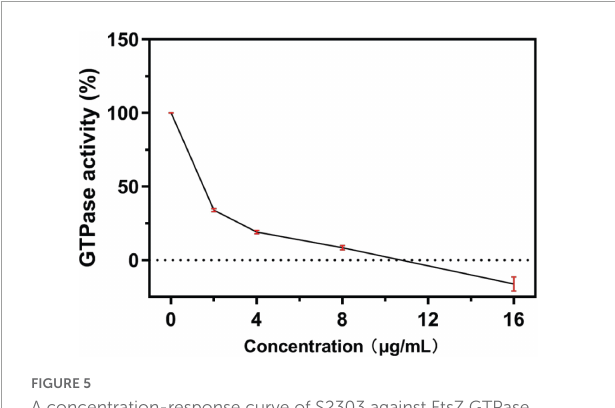
FIGURE5 A concentration-response curve of S2303 against FtsZ GTPase activity. S2303 inhibits the in vitro GTPase activity of purified S. aureus FtsZ. Reactions contained 3 µ M SaFtsZ, 50 mM MOPS pH 6.5, 5 mM MgCl 2 , 0.2 M KCl and 0.25 mM GTP and were incubated at 37 ◦ C for half an hour. Each point represents the average of three assays ( n = 3) while red vertical bars show the standard error of the mean.